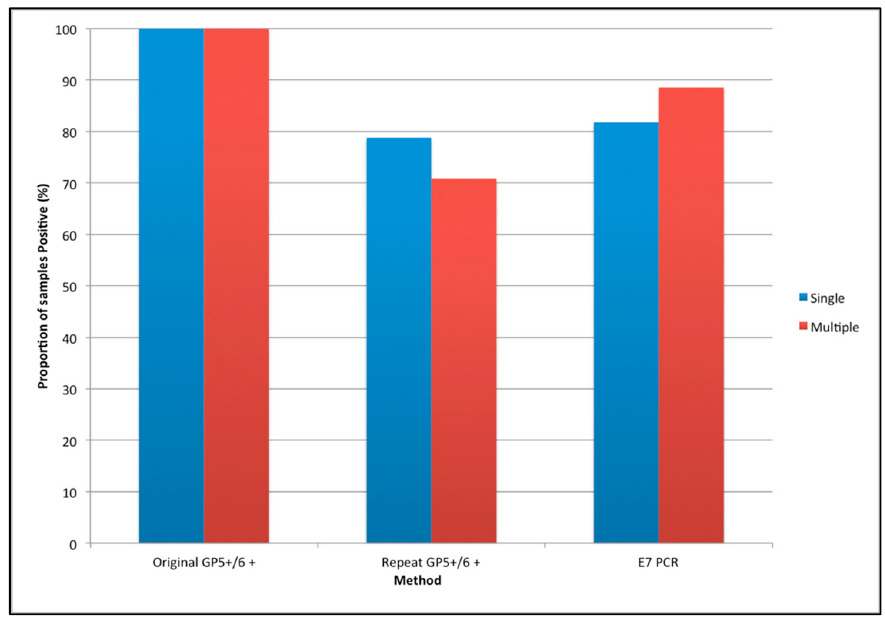
Figure 2. Proportion of samples testing HPV 51 positive by test: singles and multiples.